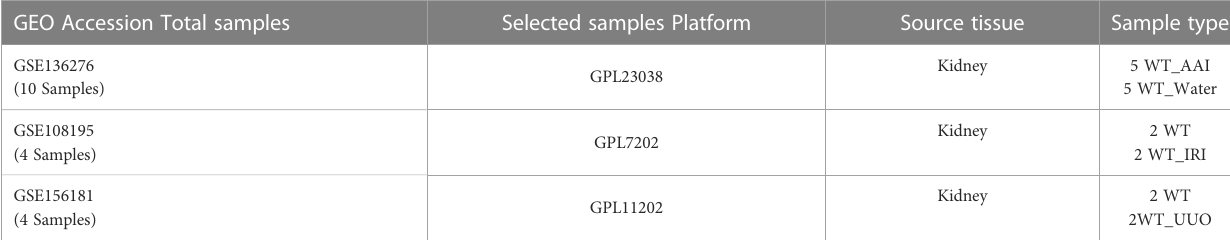
TABLE 1 Information for selected microarray